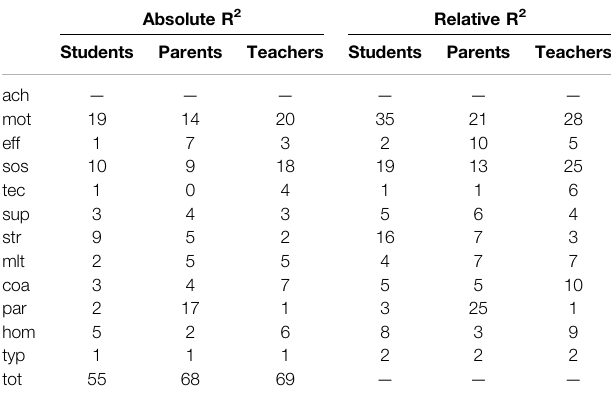
TABLE 8 | Relative weight analysis for student achievement.